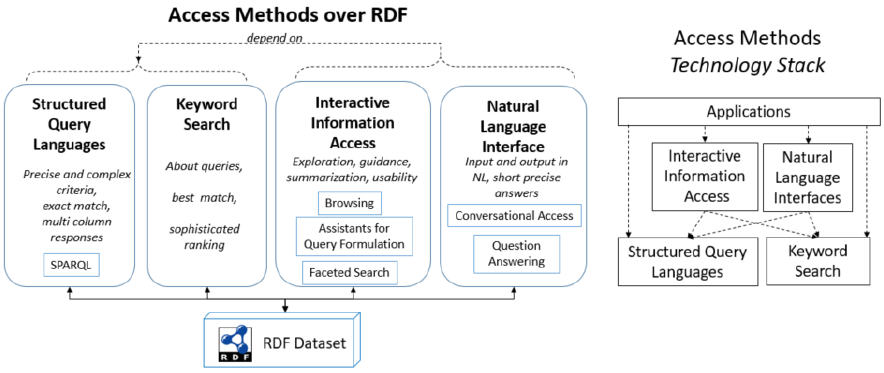
Figure 1. Access Methods over RDF.